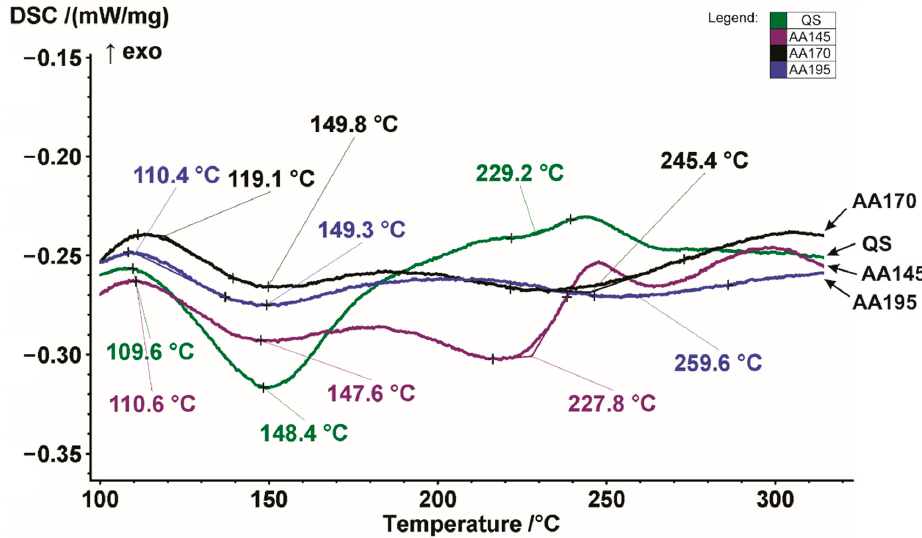
Figure 4. Detailed DSC heating curves of the examined AA7075 alloy in the quenched, and aged condition between 100 °C and 300 °C. condition between 100 ◦ C and 300 ◦